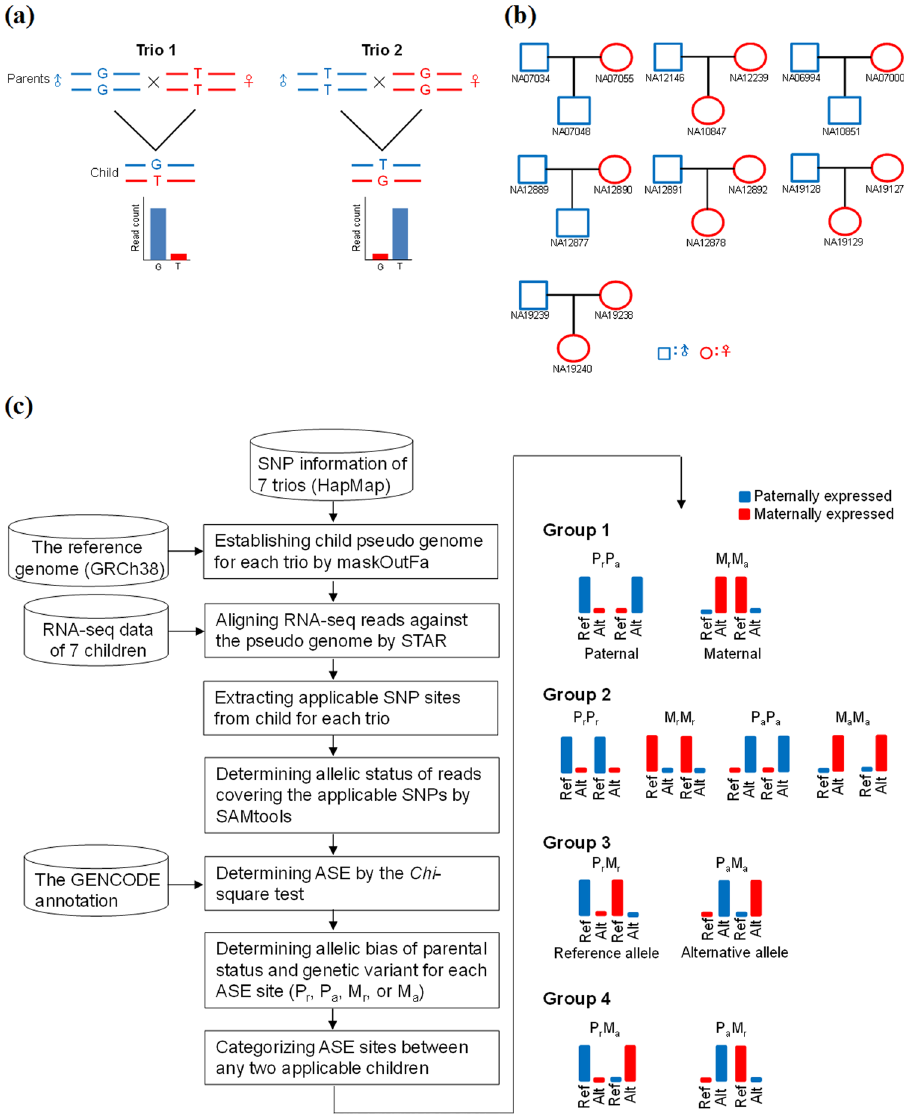
Figure 1. Identification of varied types of ASE patterns between unrelated family trios. ( a ) Schematic illustration of the RAD pattern. ASE consistently biased toward the paternal allele between two independent parent-offspring trios (i.e., Trios 1 and 2), without regard to genetic variation. ( b ) The seven family trios used in this study. ( c ) Flowchart of identification (left) of ASE events and categorization (right) of different groups of ASE patterns between any two children (see the text). P r , ASE biased toward the paternal and reference allele. P a , ASE biased toward the paternal and alternative allele. M r , ASE biased toward the maternal and reference allele. M a , ASE biased toward the maternal and alternative allele. Ref, the reference allele. Alt, the alternative